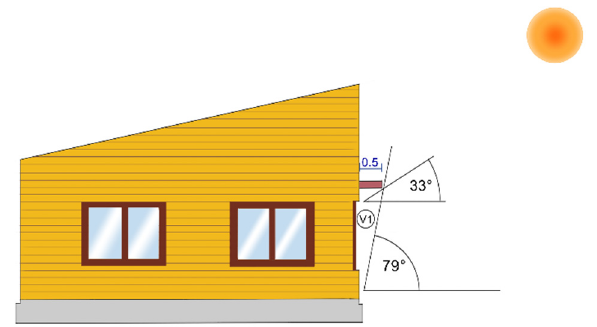
Figure 6. Shading produced by eaves on the north façade of the building. Own elaboration. The windows considered in this work correspond to double glazing with timber frame with a U-value = 1.8 W/m 2 K and g = 0.74 which is currently available in the Chilean market [46]. This type of windows has a transmittance that is 38% lower than that established as the limit for traditional windows (2.9 W/m 2 K) in current Chilean regulations [47].